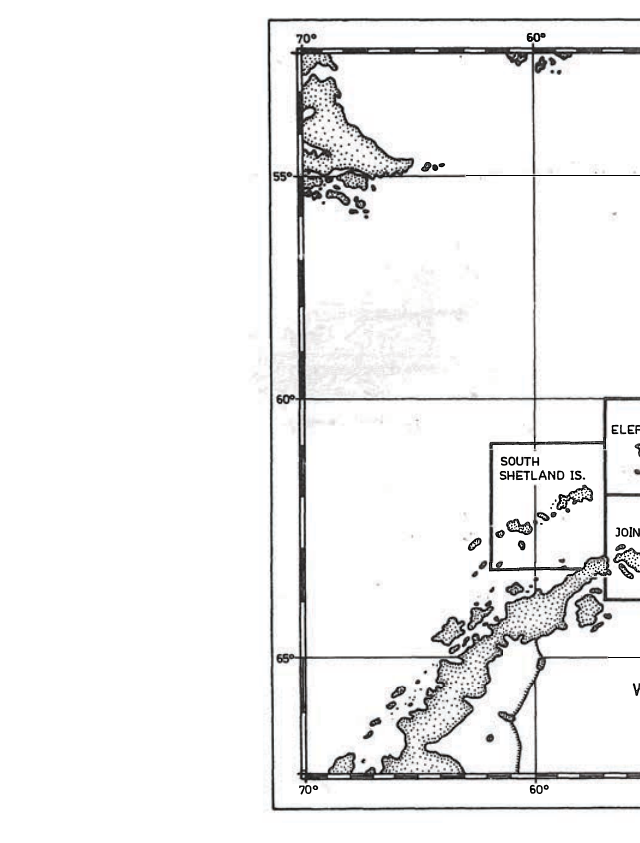
Fig. 1. The areas of